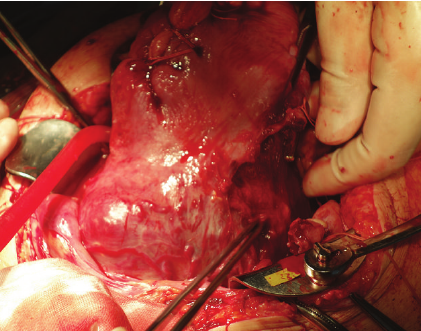
Figure 3: Operative findings. After delivery of the baby through a vertical incision in the uterine corpus, no myometrium was detected in the lower uterus and the placenta was visible through the uterine wall; these findings were consistent with a cesarean scar